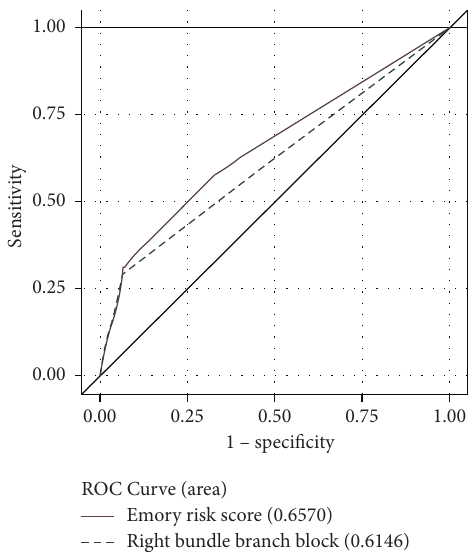
Figure 2: ROC curve for self-expanding